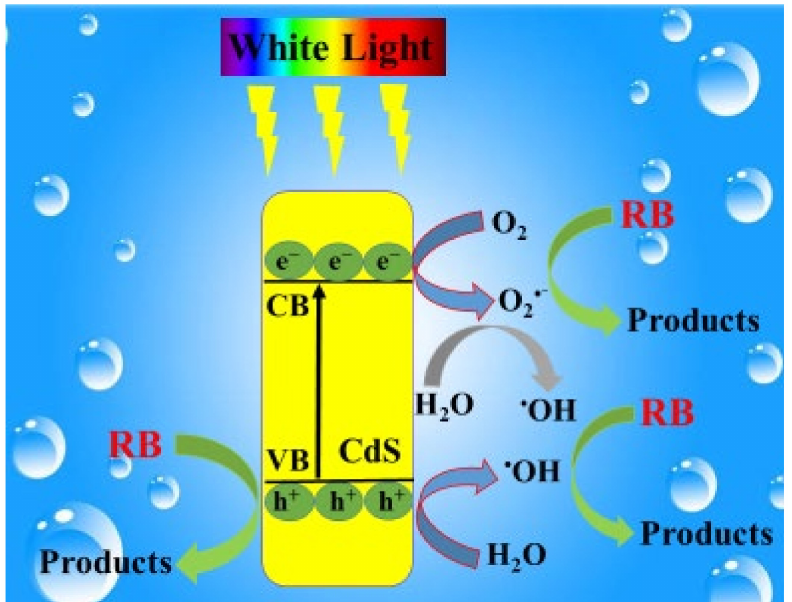
Figure 10. Proposed mechanism for the photocatalytic degradation of RB under visible light